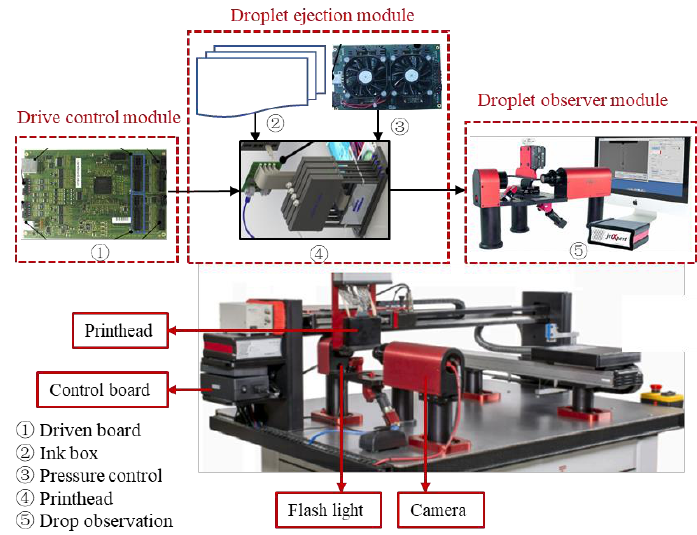
Figure 3. Experimental platform.